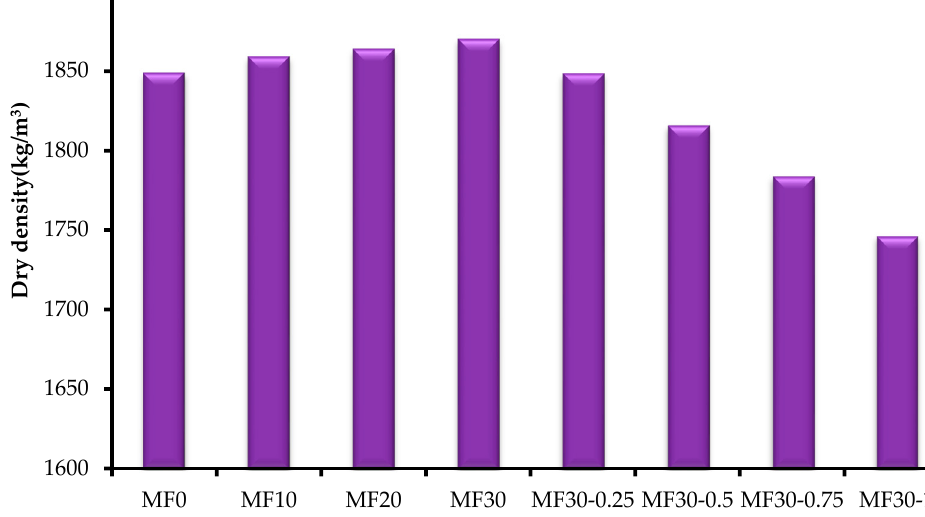
Figure 4. Concrete dry density.